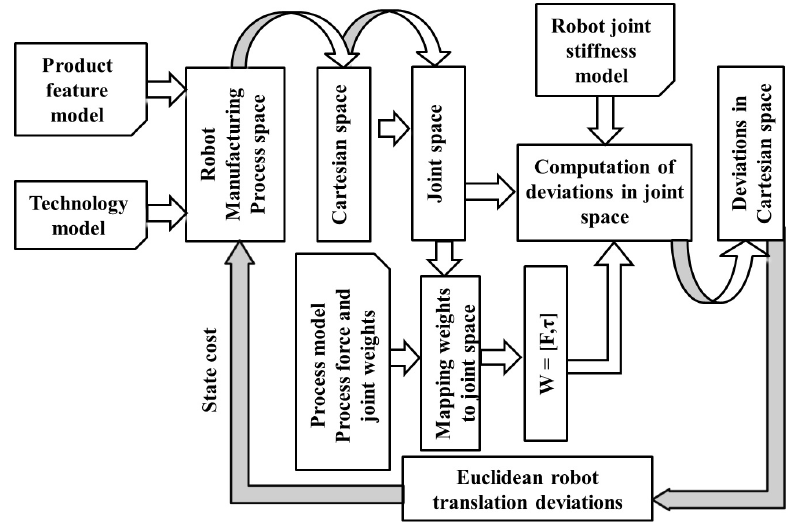
Figure 7. State cost